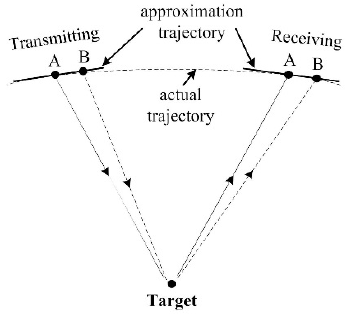
Figure 4. The continuous tangent model.